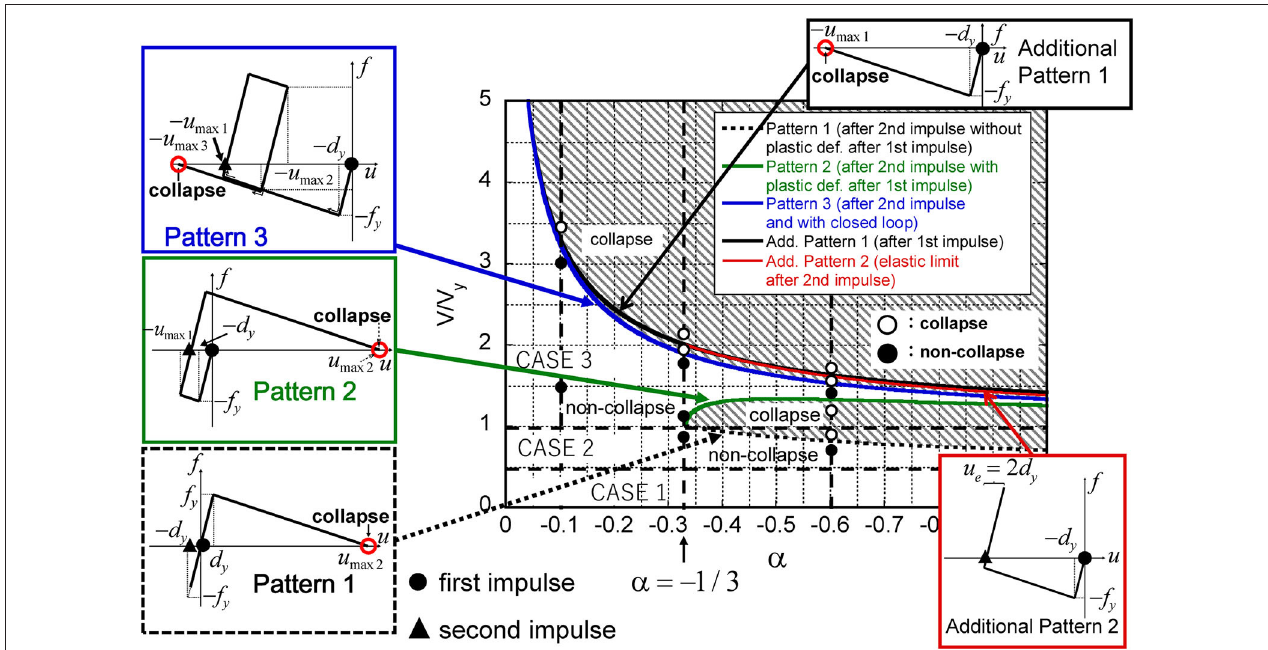
FIGURE 2 | Regions of collapse and non-collapse and several patterns of collapse limit (patterns of